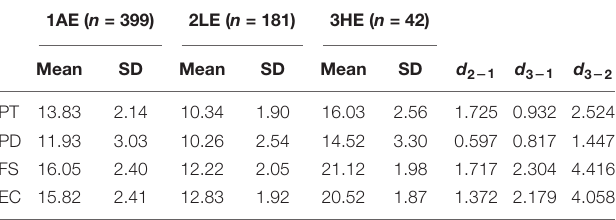
TABLE 4 | Mean, standard deviation of empathy and Cohen’s d of the three-profile solution of empathy among nursing students ( n = 622). 1AE ( n = 399)